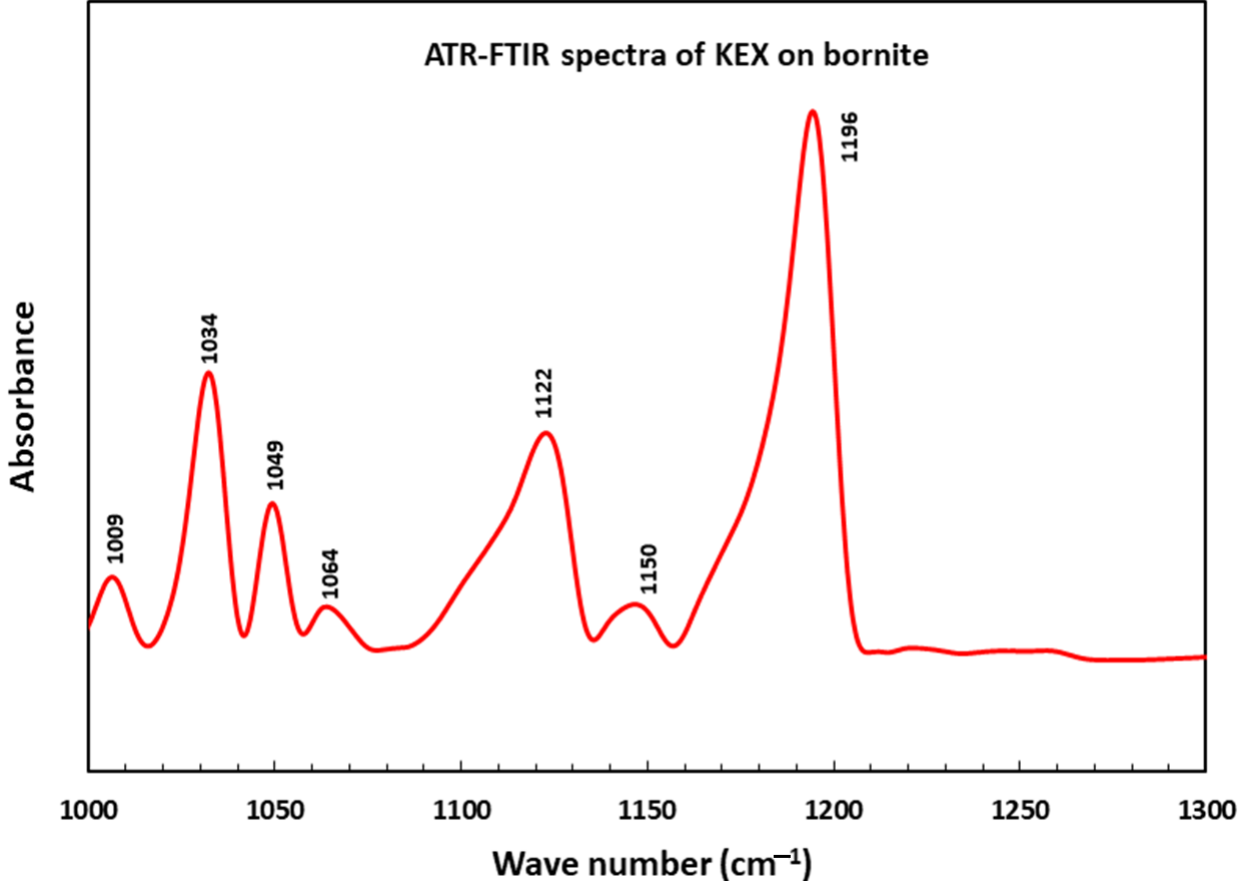
Figure 17. ATR-FTIR spectra of a bornite surface after it contacted the 5 × 10 − 4 M KEX solution at pH 6 for 1 h.